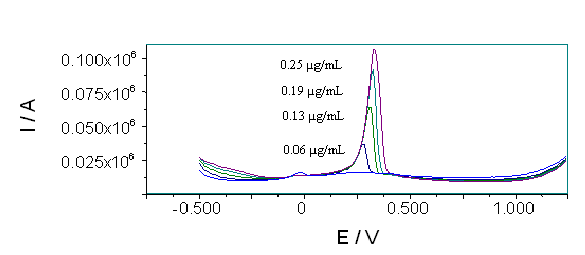
Figure 2: Differential pulse anodic stripping voltammograms obtained for determination of Ag + in mixture of BR buffer at pH 4.1 / ethylene glycol (100/1, v/v) on glassy carbon electrode.